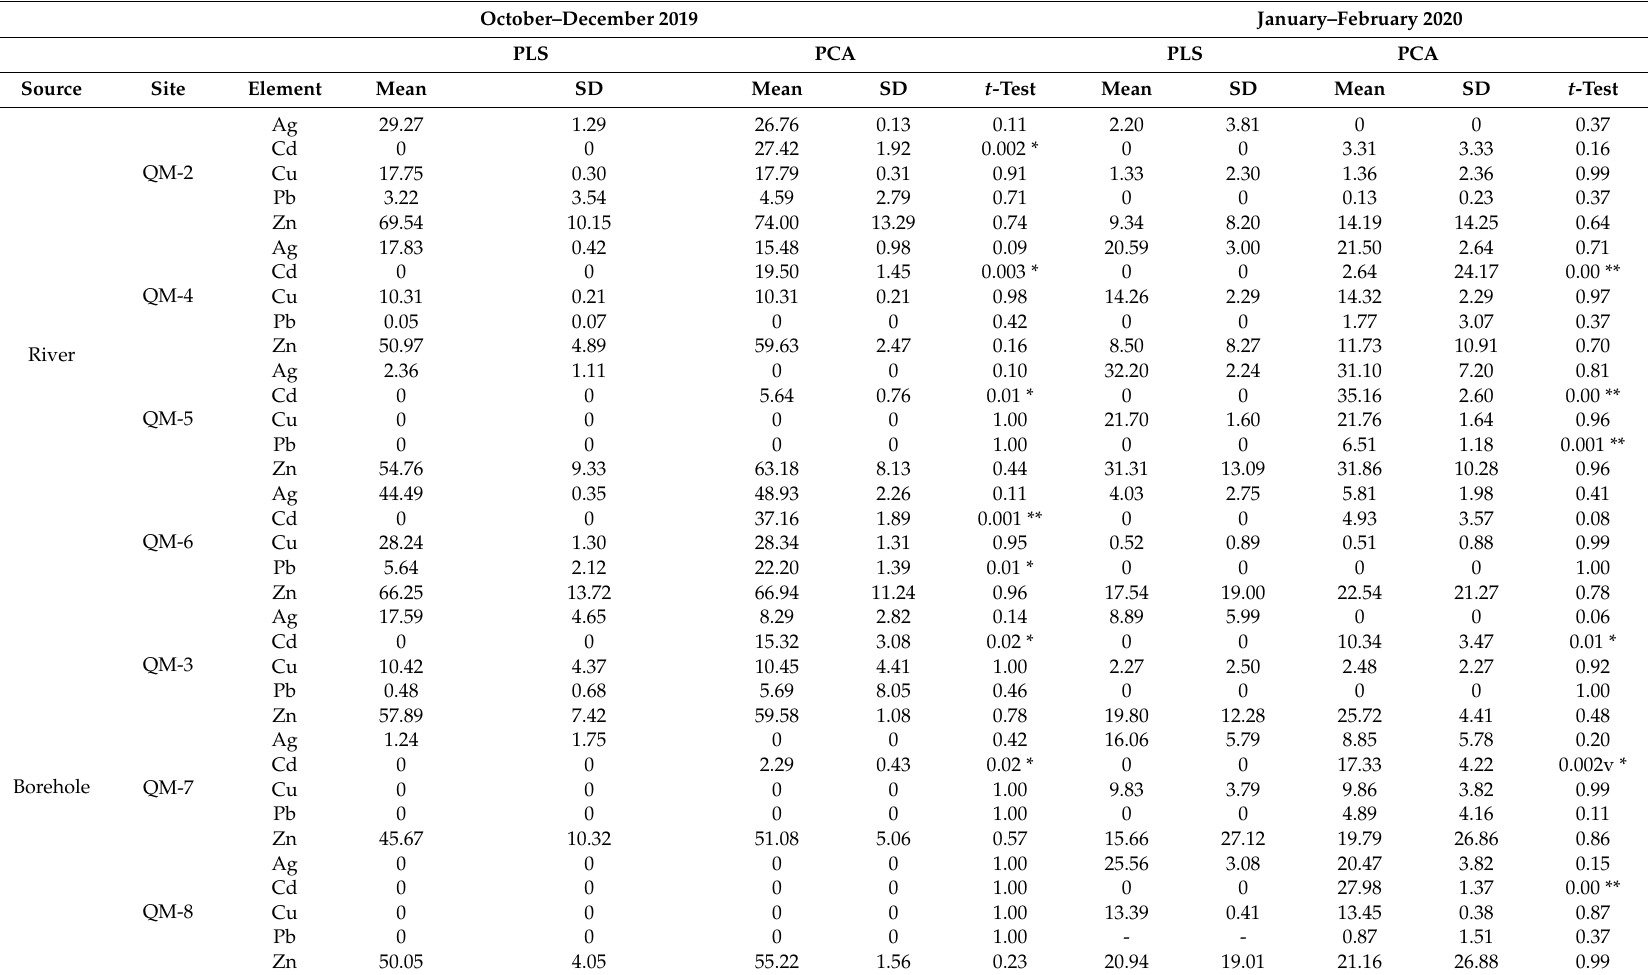
Table 3. Comparison of heavy metal concentration (mg L − 1 ) in water sources as determined with the PLS and PCA